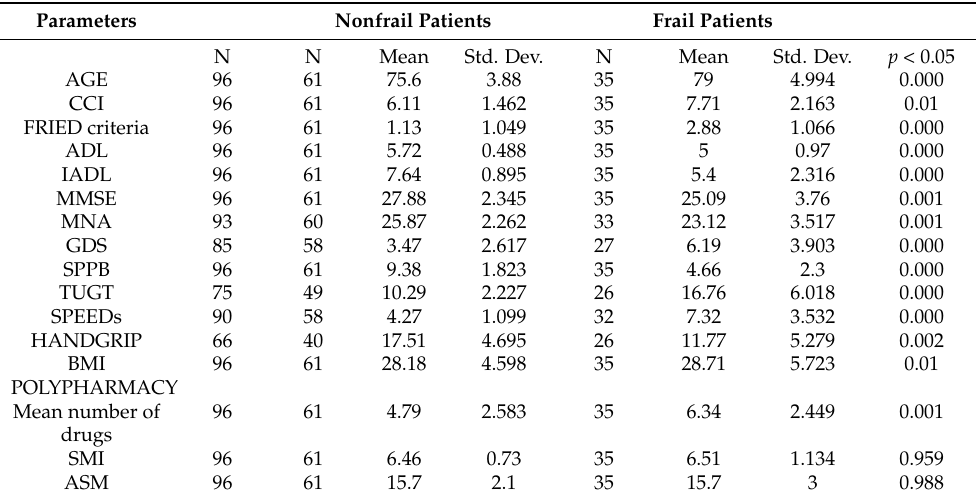
Table 3. Characteristics of frail and nonfrail patients (based on comprehensive geriatric assessment (CGA)